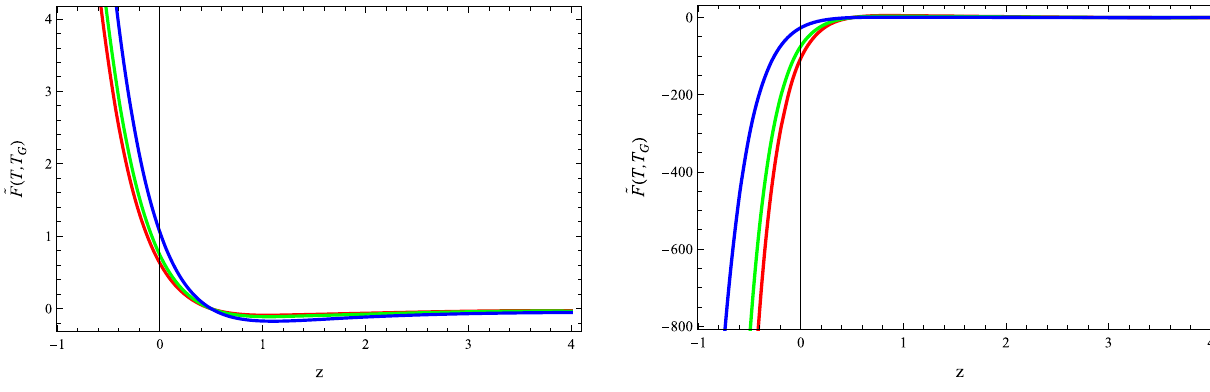
Fig. 15 Plots of intermediate reconstructed GGPDE ˜ F ( T , T G ) model for u = 2 (left) and − 2